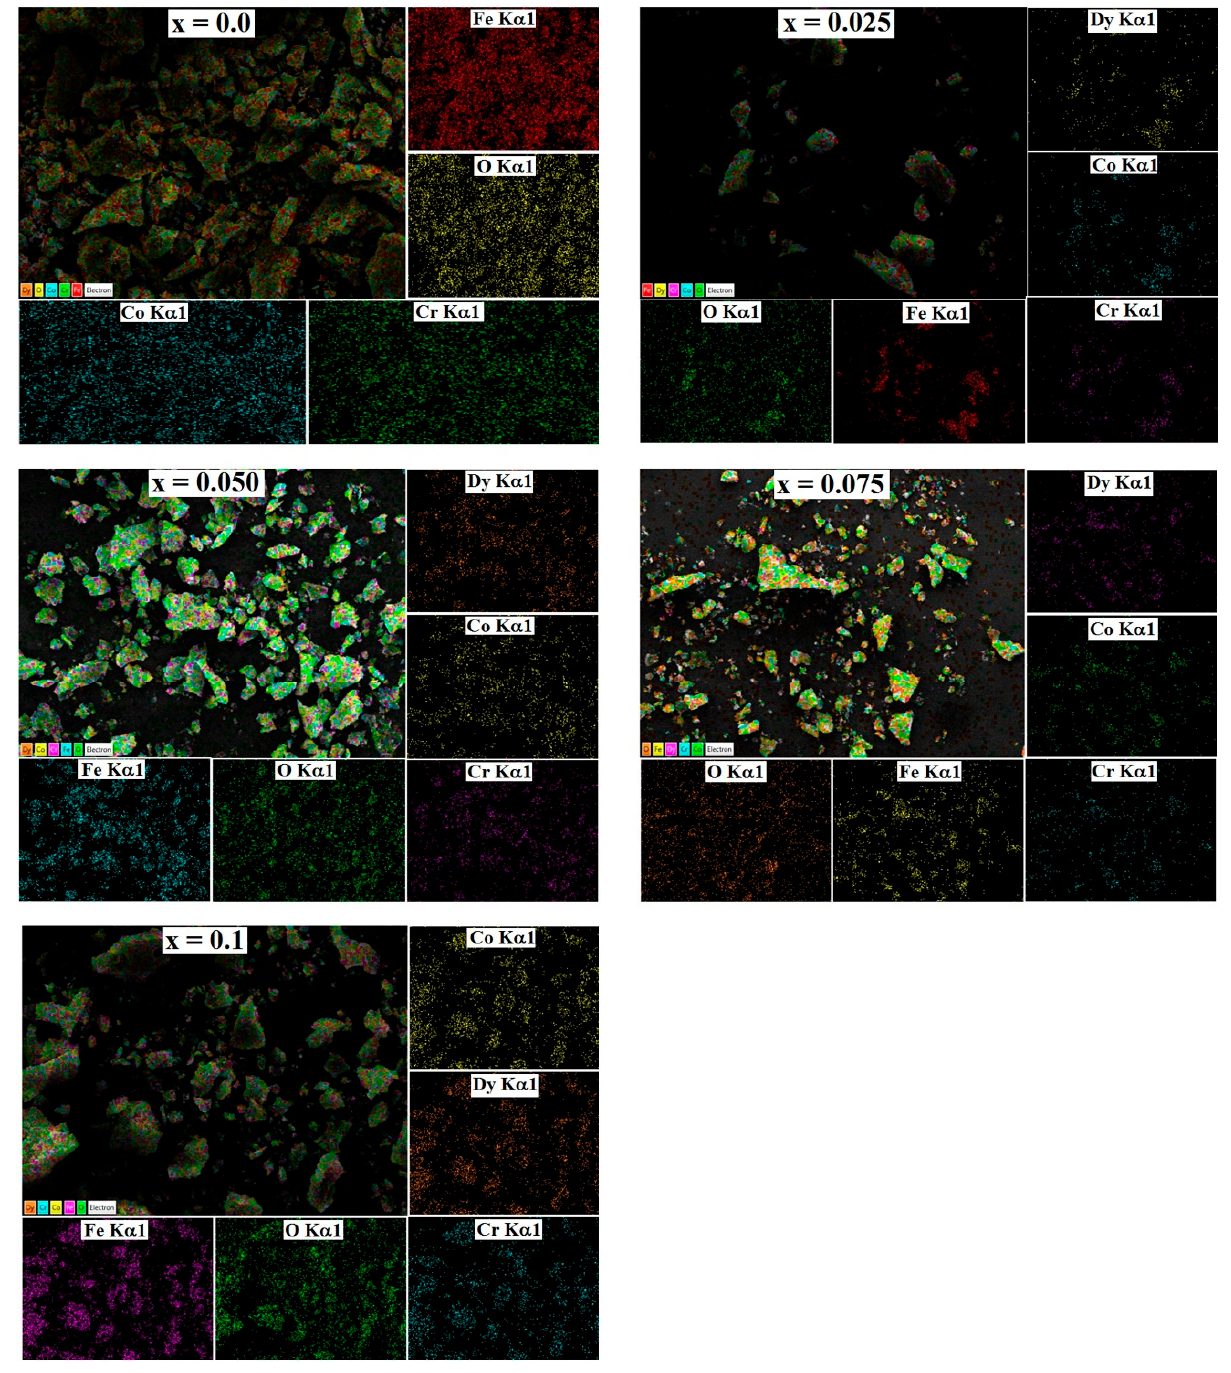
Figure 7. Elemental colour mapping of all the samples of CoCr 0.5 Dy x Fe 1.5 − x O 4 where x = 0.0, 0.025, 0.05, 0.075 and 0.1.